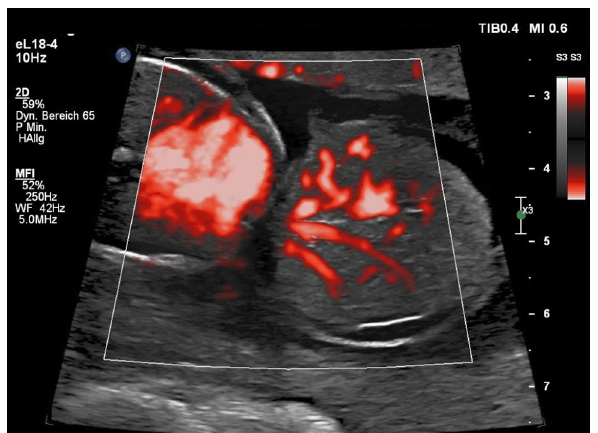
Figure 2. Big exomphalos with liver